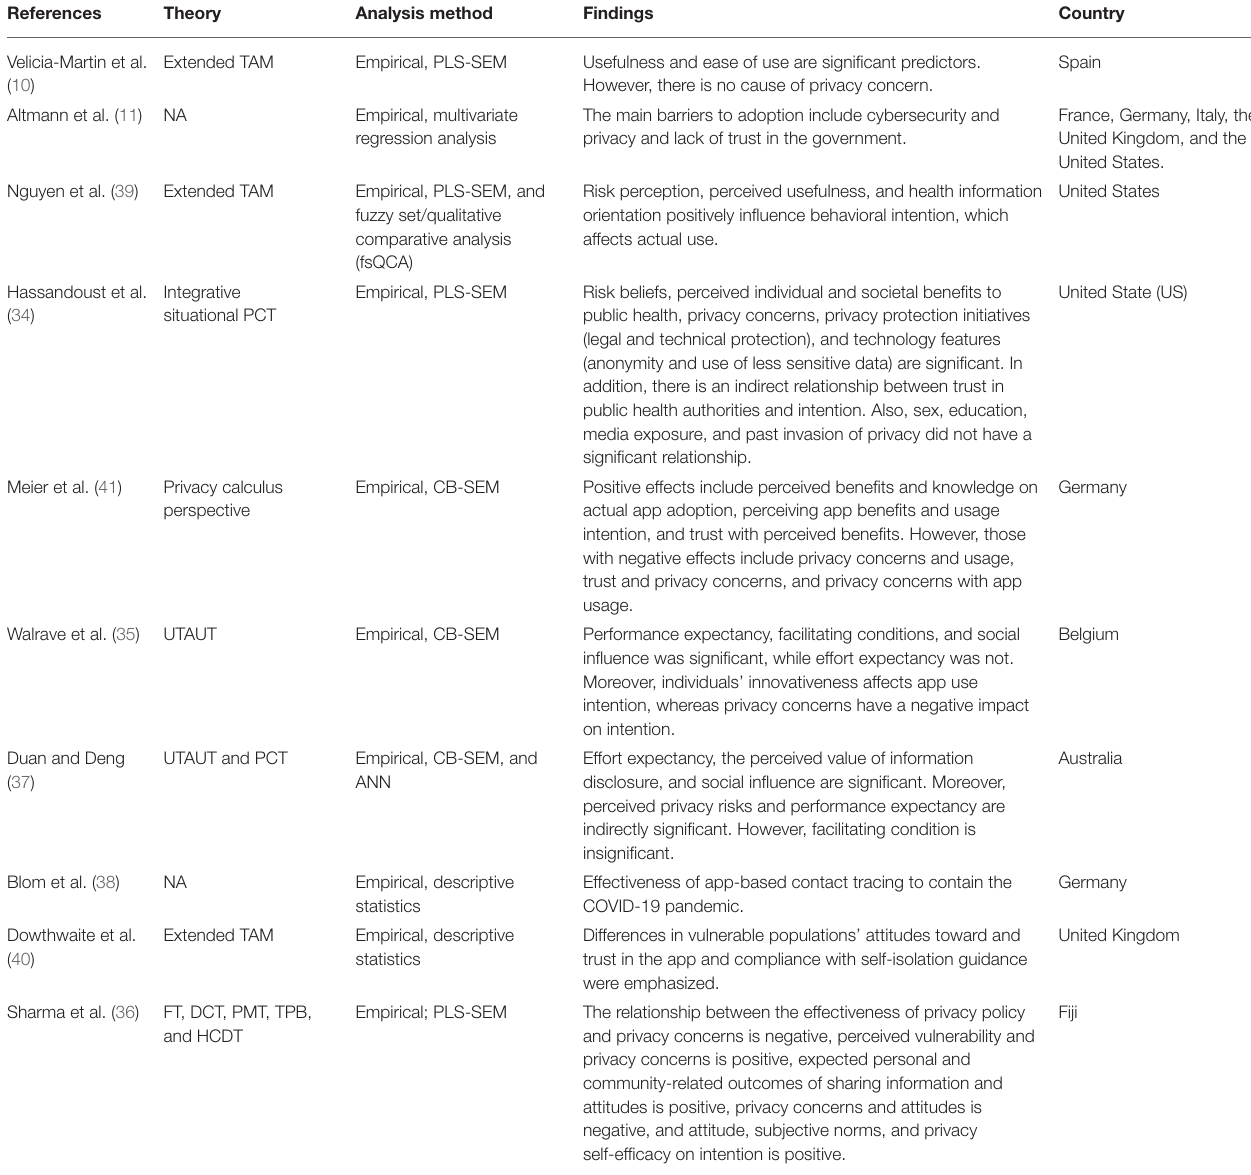
TABLE 1 | Summary of existing CTA adoption